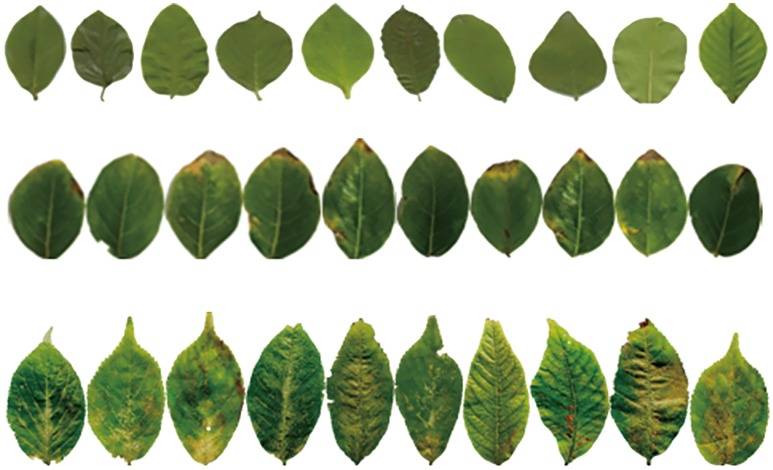
Some plant leaves.